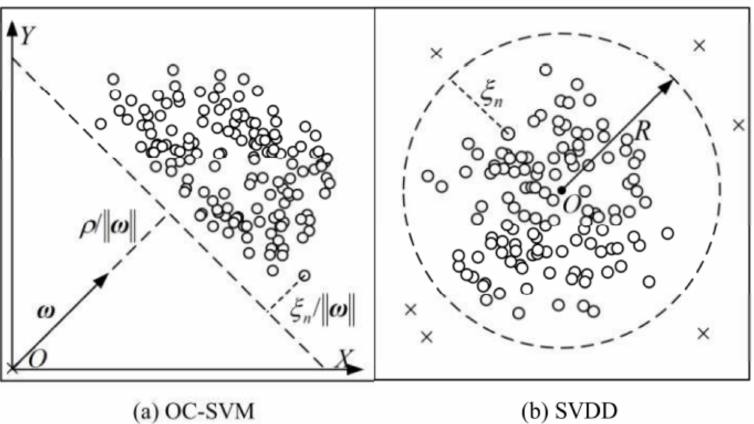
Figure 2. Schematic diagram of the classic single classification